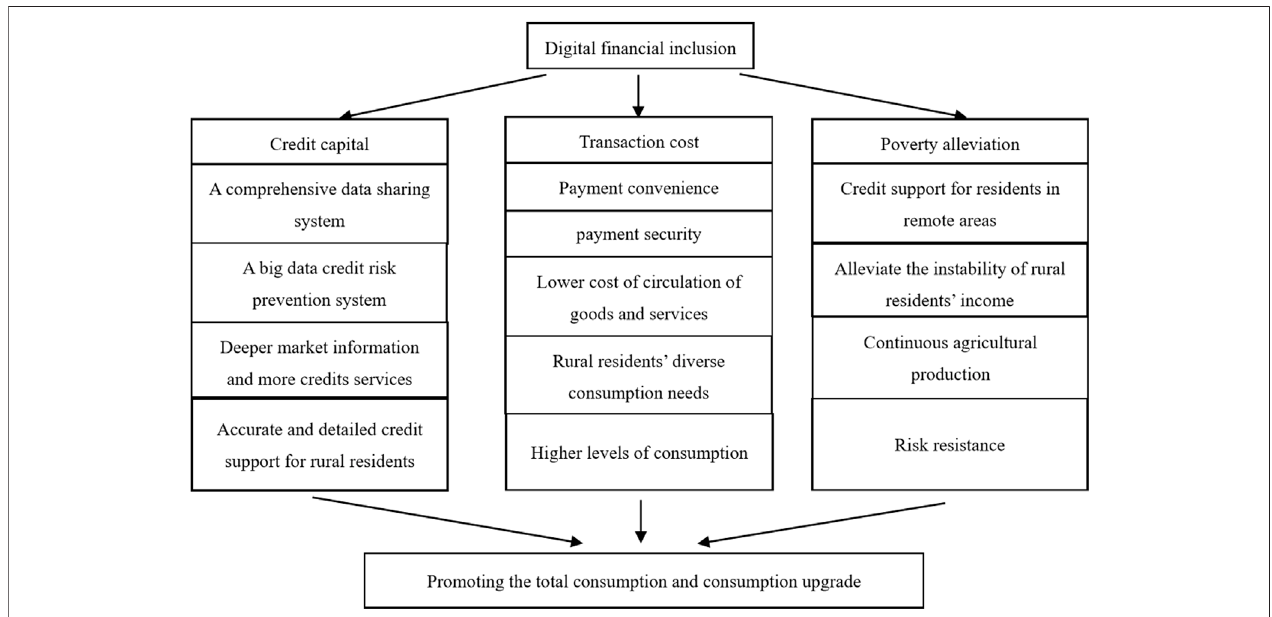
FIGURE 5 | Theoretical framework of how digital fi nancial inclusion affects